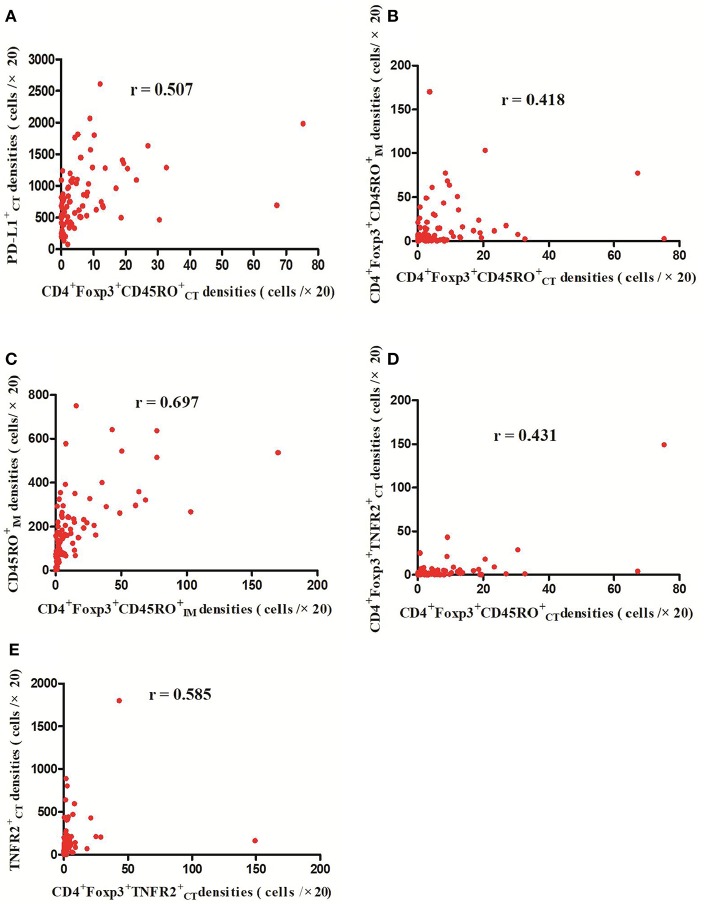
Positive correlations between CD4+Foxp3+CD45ROCT+ and PD-L1CT,+ CD4+Foxp3+CD45ROIM,+ and CD4+Foxp3+TNFR2CT+ cell densities, respectively (p < 0.01) (A,B,D); Meanwhile, CD4+Foxp3+CD45ROIM+ cell densities were positively related with CD45ROIM+ cell densities (C) (p < 0.01) and CD4+Foxp3+TNFR2CT+ cell densities were positively correlated with TNFR2CT+ cell densities (p < 0.01) (E).